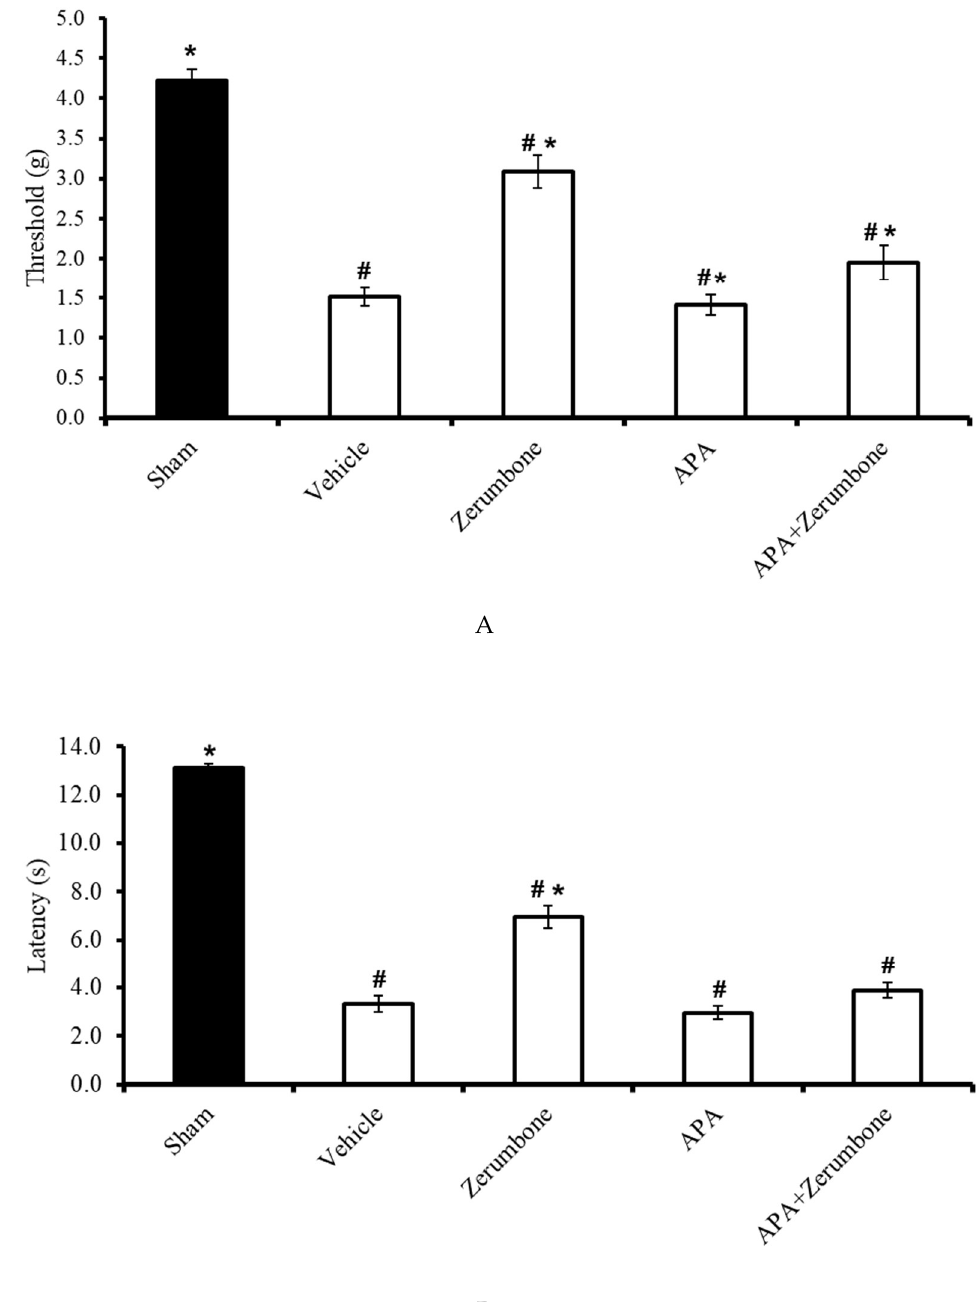
Figure 3. Effect of zerumbone (10 mg/kg; i.p.) and pre-treatment with a small-conductance Ca 2+ - activated K + channel inhibitor (apamine, APA; 0.04 mg/kg; i.p.) on the responses toward ( A ) mechanical allodynia and ( B ) thermal hyperalgesia on CCI-induced neuropathic pain in mice. Each column represents the mean ± SEM; n = 8 mice per group. Note: # significantly different ( p ≤ 0.05) than sham group; * significantly different ( p ≤ 0.05) than vehicle group (one-way ANOVA followed by Tukey’s post hoc test).